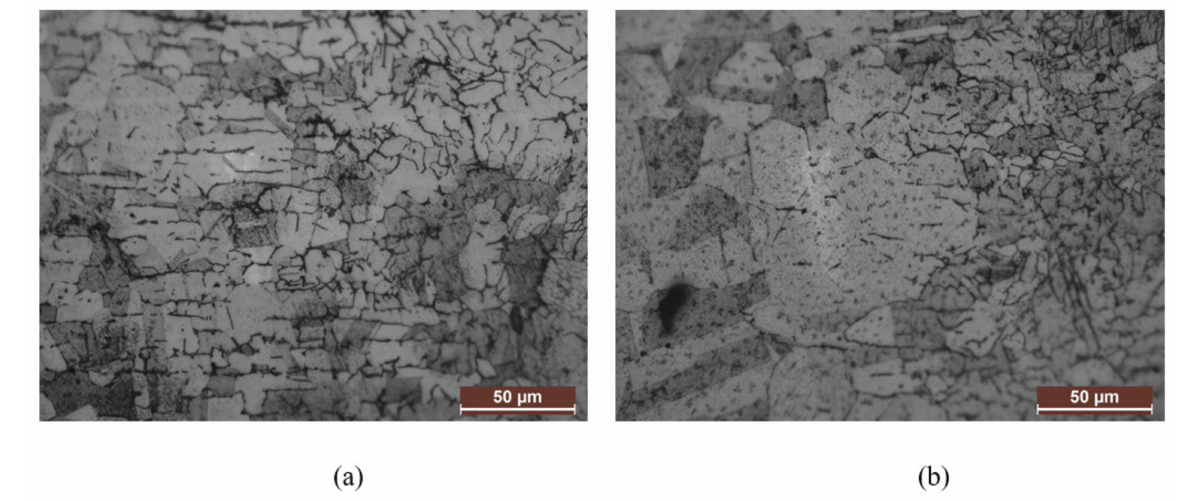
Figure 14. Difference in grain size within the heat-affected zone (HAZ) on welding using ( a ) pure Ar; ( b ) 10% N 2 + Ar for shielding.